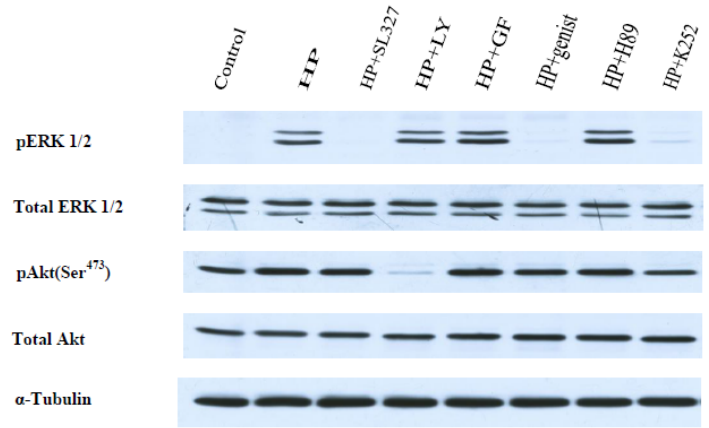
inhibitors before cell exposure to 0.3 mM H immunoblotting studies; ( B ) Effect of protein kinase inhibitors on pERK 1/2 level in PC12 cells; ( C ) Effect of protein kinase inhibitors on pAkt level in PC12 cells. In ( B , C ): x,xx the xx p < 0.05. In the figure, LY is 50 μ M LY294002, GF is 1 μ M GF109203X, genist